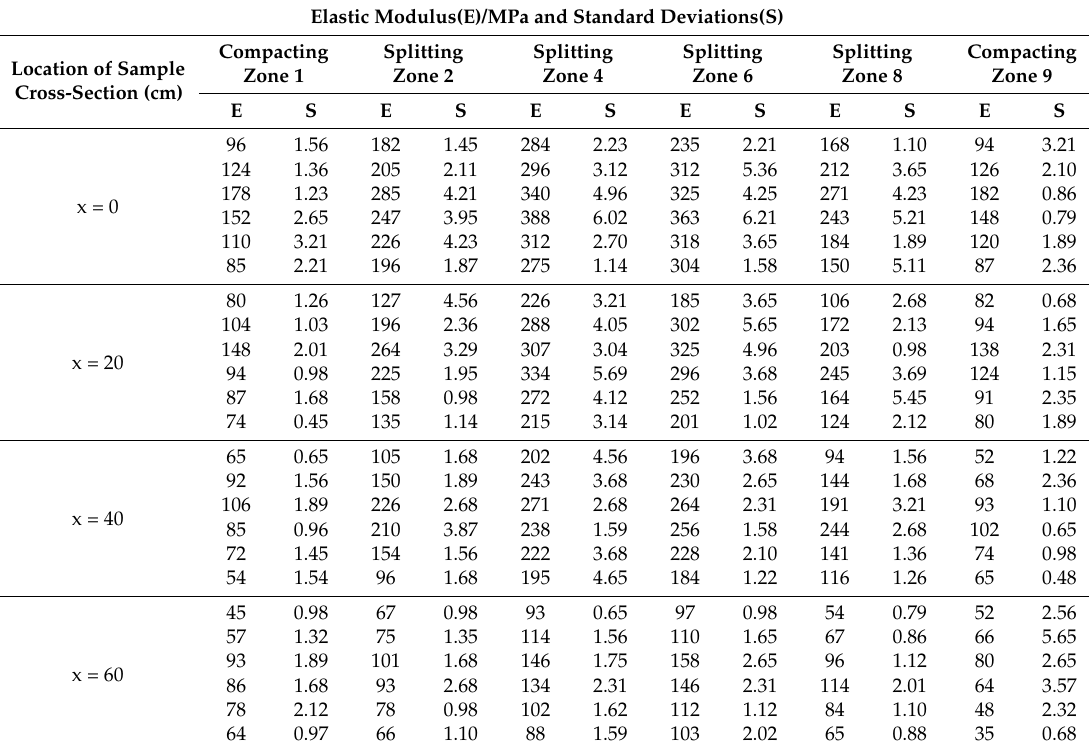
Table 4. Data sheet of the specimens in the splitting and compacting zone. Elastic Modulus(E)/MPa and Standard